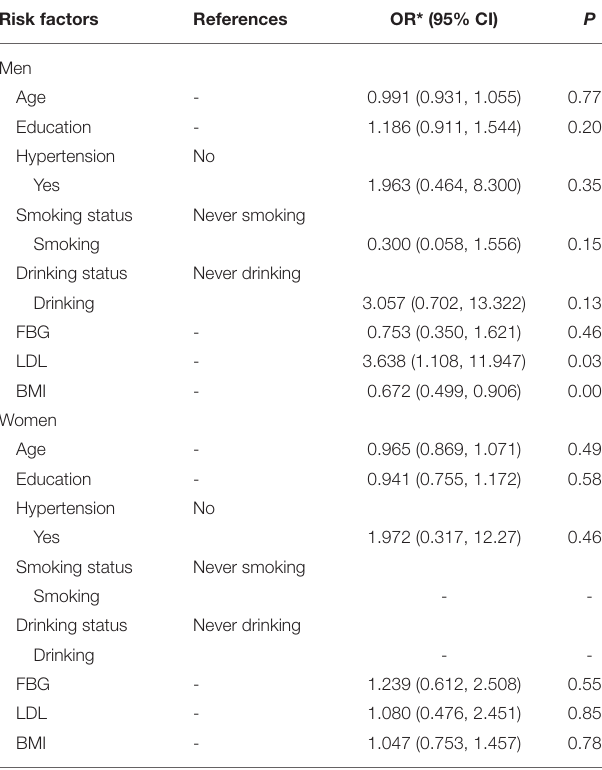
TABLE 4 | Multivariate analysis the BMI group between BMI and intracranial aneurysms among people with family history of stroke. Risk factors